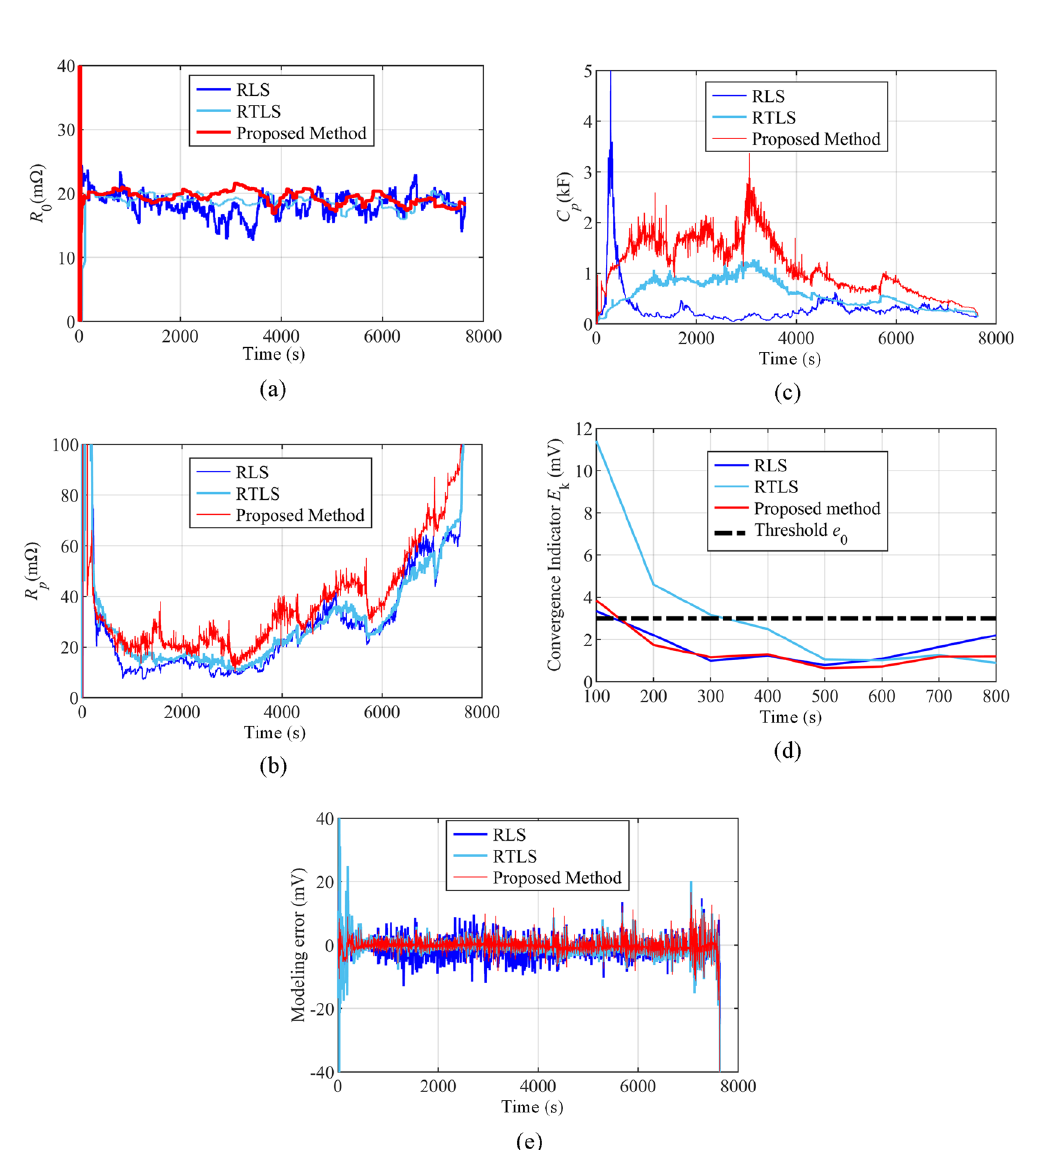
Figure 9 Experimental results of the parameter identification under the UDDS driving cycles (25 °C): ( a ) R 0 , ( b ) R p , ( c ) C p , ( d ) E k , ( e ) Modeling